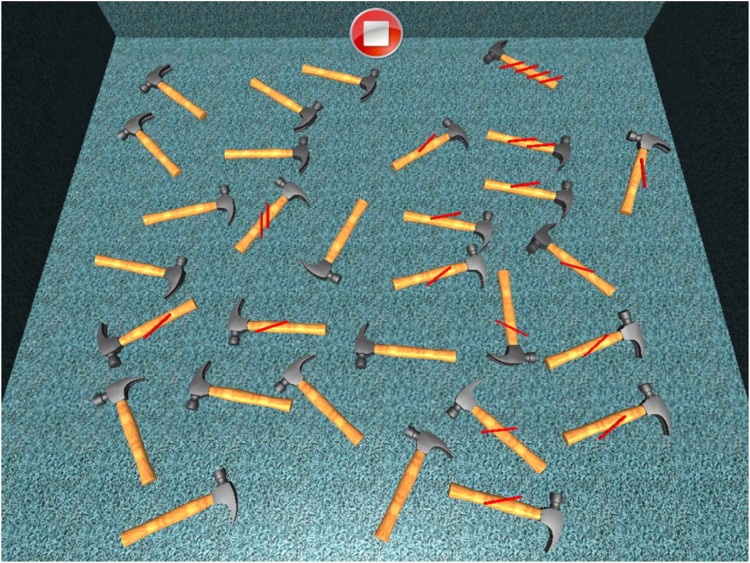
Simple barrage task.